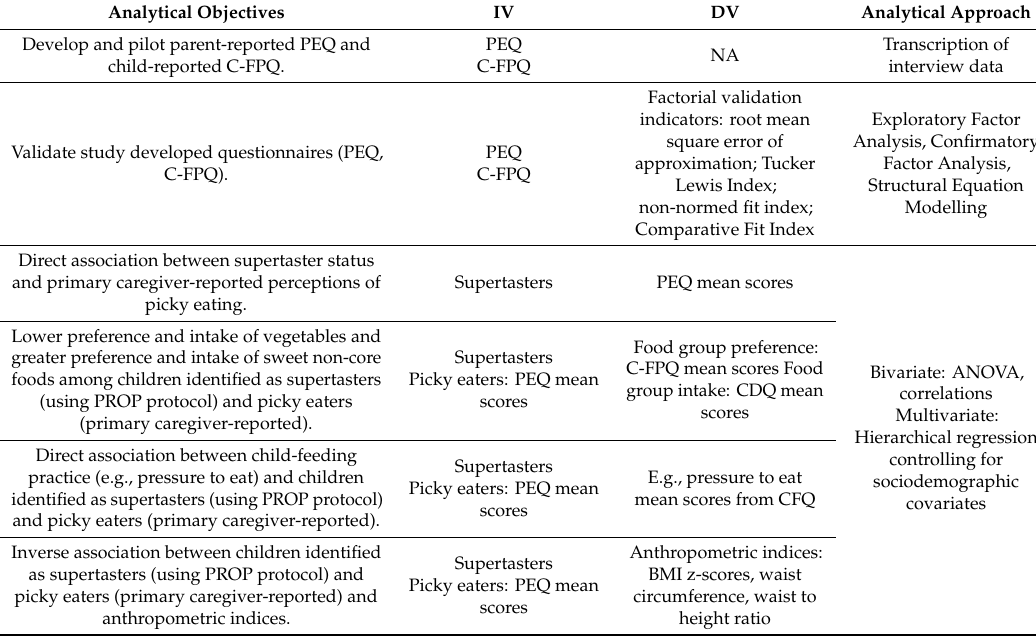
Table 2. Brief analytical plan to be